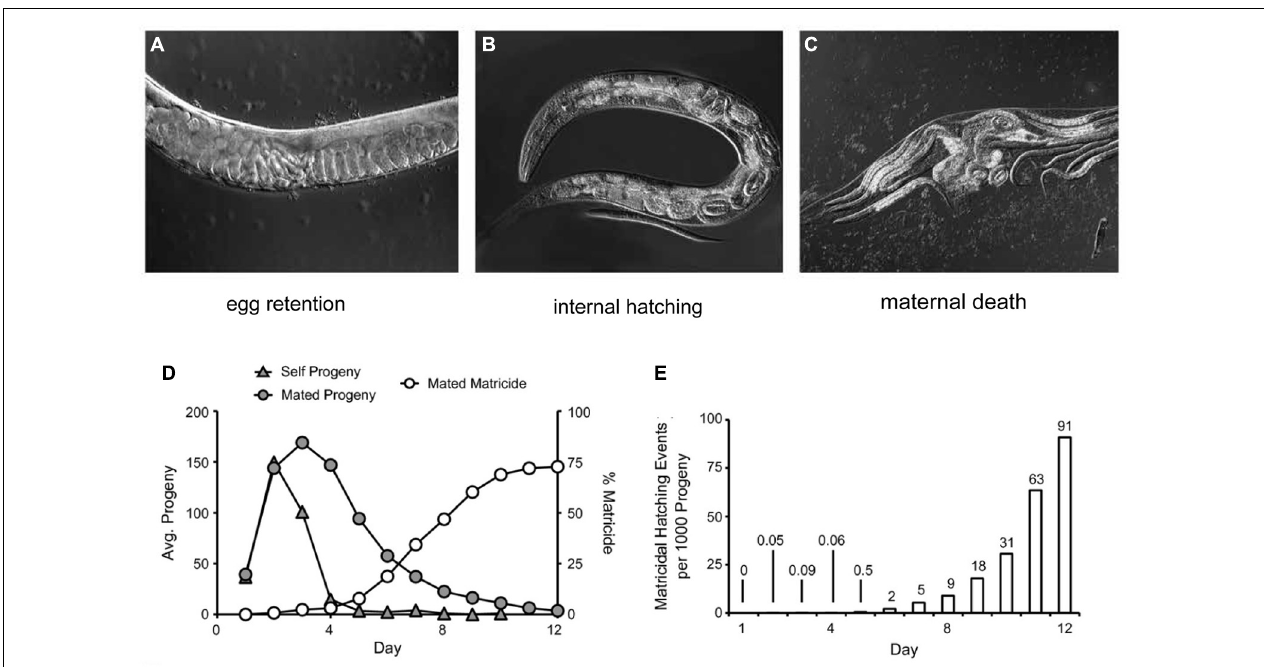
FIGURE 4 | Matricidal hatching. Wild strain JU751 hermaphrodites exhibit nearly constitutive matricidal hatching. DIC microscopic micrographs depict the progression: (A) Eggs are retained in the uterus, showing a “stacking of embryos” phenotype. (B) Retained embryos will continue to develop and hatch inside the uterus. (C) Hatched larvae grow inside the hermaphrodite and feed on the maternal tissue. Finally, the hermaphrodite bursts and releases the progeny in dauer stage. (A–C) Adapted from Vigne et al. (2021). (D) The cumulative percentage of matricidal hatching in mated wild-type hermaphrodite in comparison to progeny production curves of unmated/self-fertile and mated wild-type hermaphrodites. Adapted from Pickett and Kornfeld (2013). (E) Incidence number of matricidal hatchings per 1,000 progeny laid by mated wild-type hermaphrodites. Until day 6, progeny production carries a small risk of matricidal hatching, but after day 6 the risk increases exponentially. Adapted from Pickett and Kornfeld